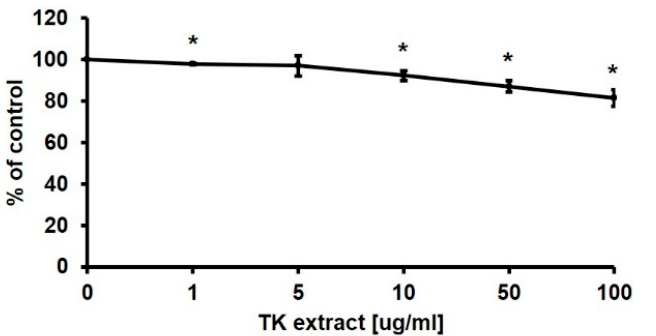
Figure 5. MTT assay results of Hs68 cells after TK extract treatment. Hs68 cells were treated with indicated concentrations of TK extract. The cell viability was evaluated with an MTT assay. (*: p < 0.05.)